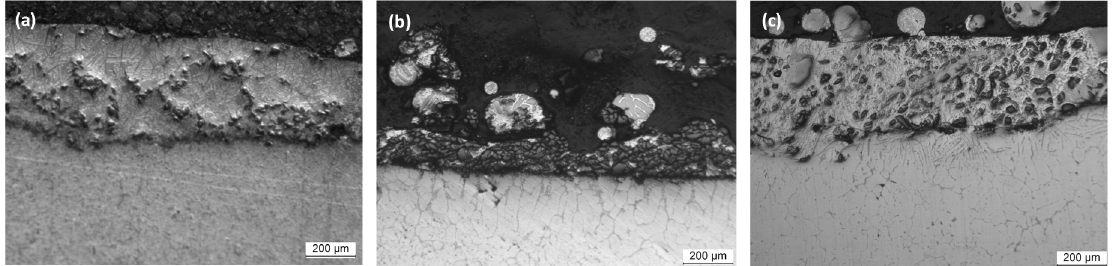
Figure 1. Cross section of the coatings deposited on the AA6082 alloy by laser cladding: ( a ) Al12Si / SiC; ( b ) Al40Si / SiC; ( c ) Al12Si-Ti / SiC.